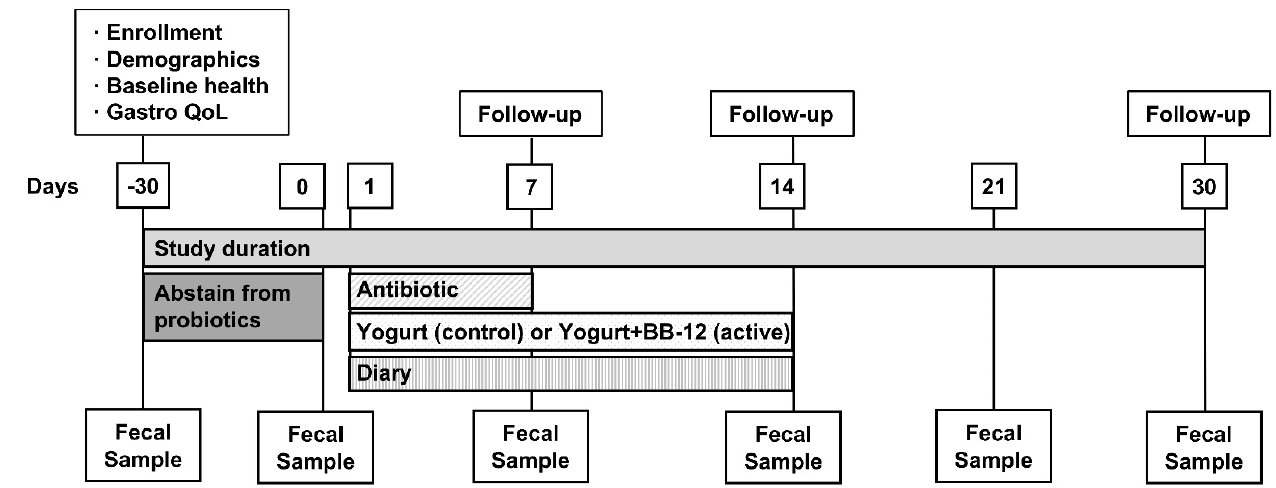
Figure 1. Participant timeline and sample/data collection schedule.